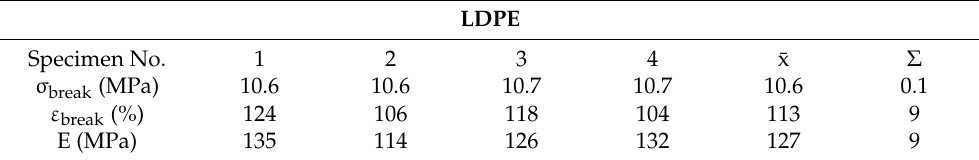
Table 3. Tensile results of LDPE.